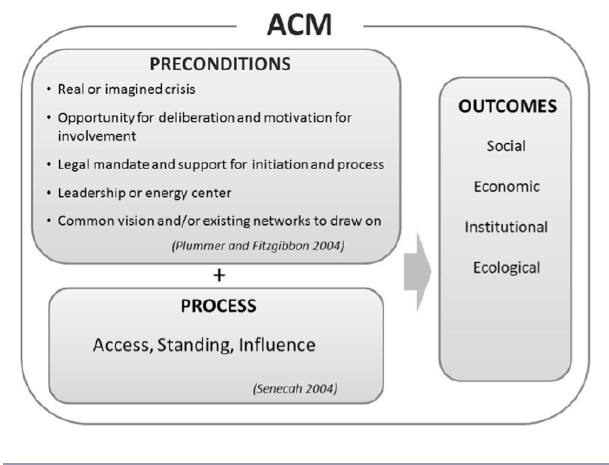
Fig. 1 . Conceptual framework integrating Adaptive